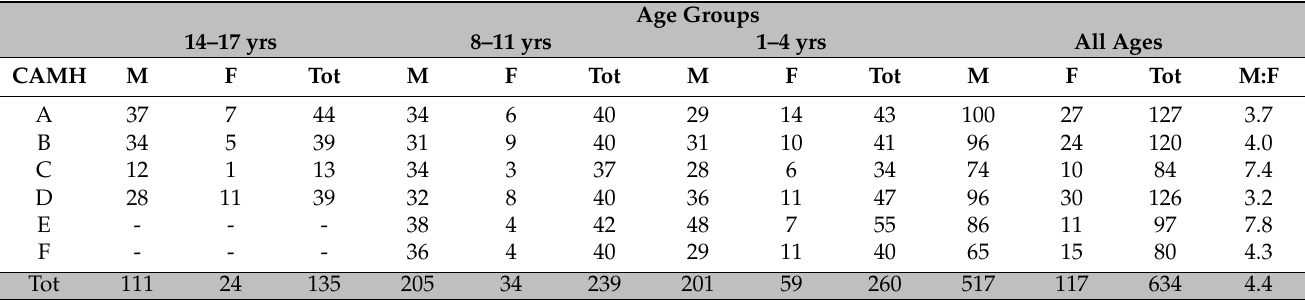
Table 2. Distribution of subjects by CAMH unit, age group and